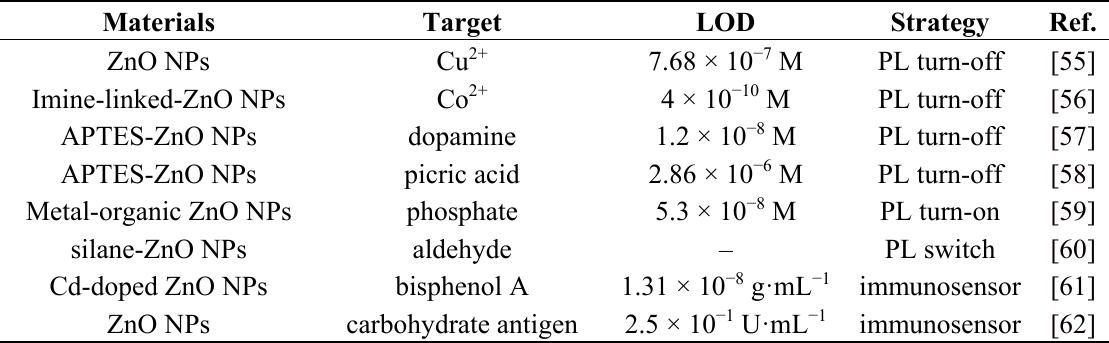
Table 2. Typical researches about luminescent sensors of ZnO